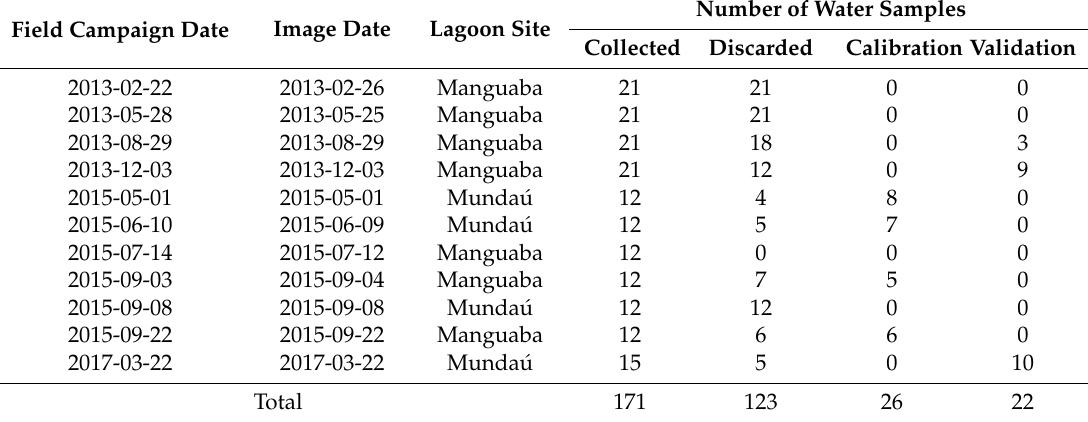
Table 2. Data of each field campaign and the number of collected water samples in MMELS. From this total, 26 and 22 sampling stations were used to calibrate and validate the NIR-Red band ratio model,